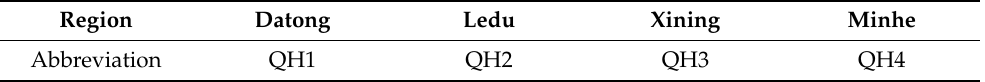
Figure 2. Phase composition and microscopic morphology of the silica fume. Table 2. Abbreviations, gradations, and percentage contents of the four types of quartz sand aggregates. Region